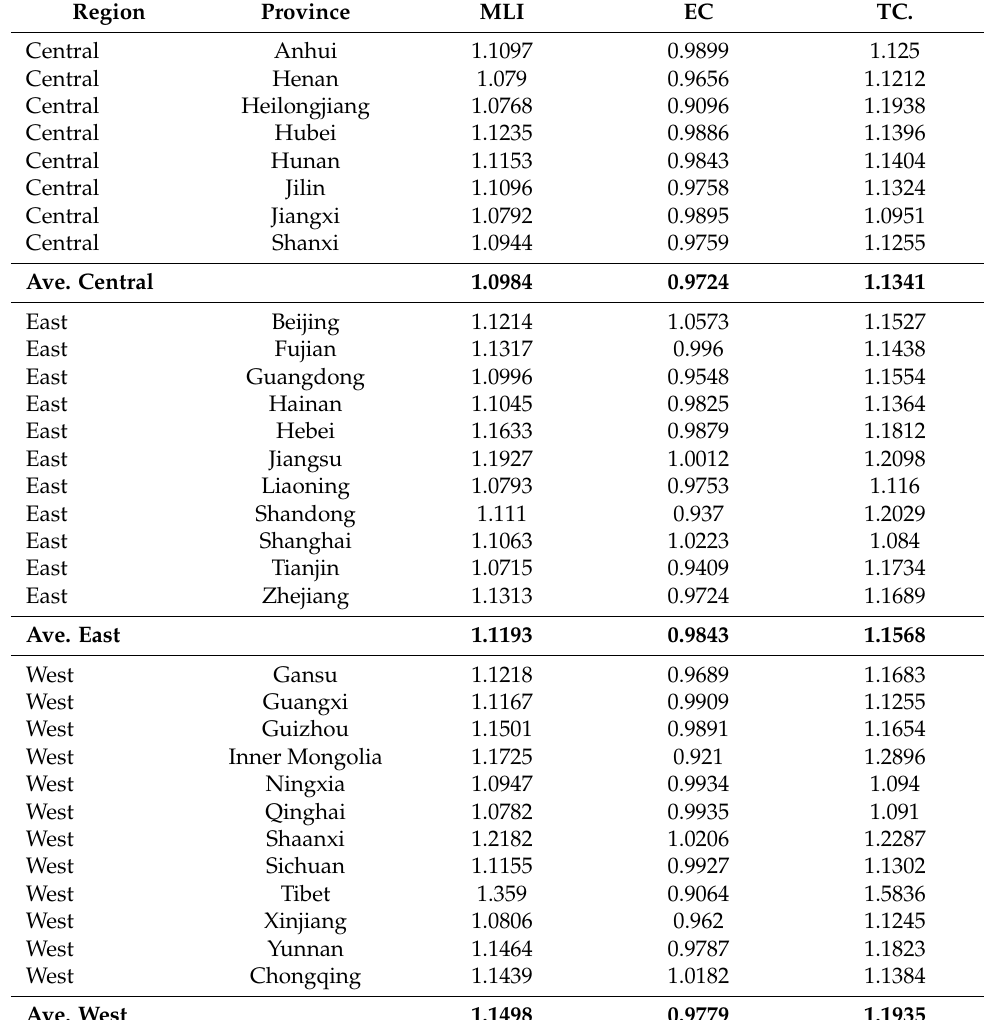
Table 4. Average MLI, EC, and TC in three different regions of China (2006–2020).